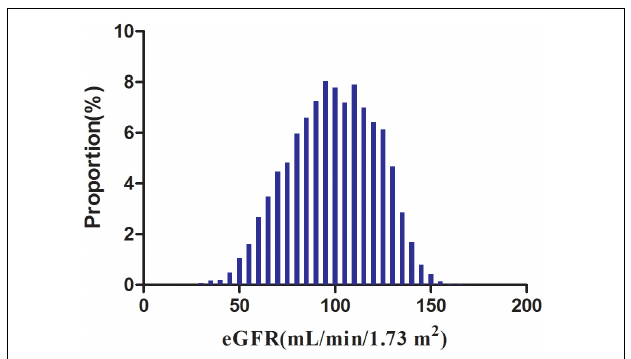
FIGURE 2 | Distribution of eGFR. It presented a normal eGFR distribution while being in the range from 29.42 to 167.11 mL/min per 1.73 m 2 , with an average of 98.83 mL/min per 1.73 m 2